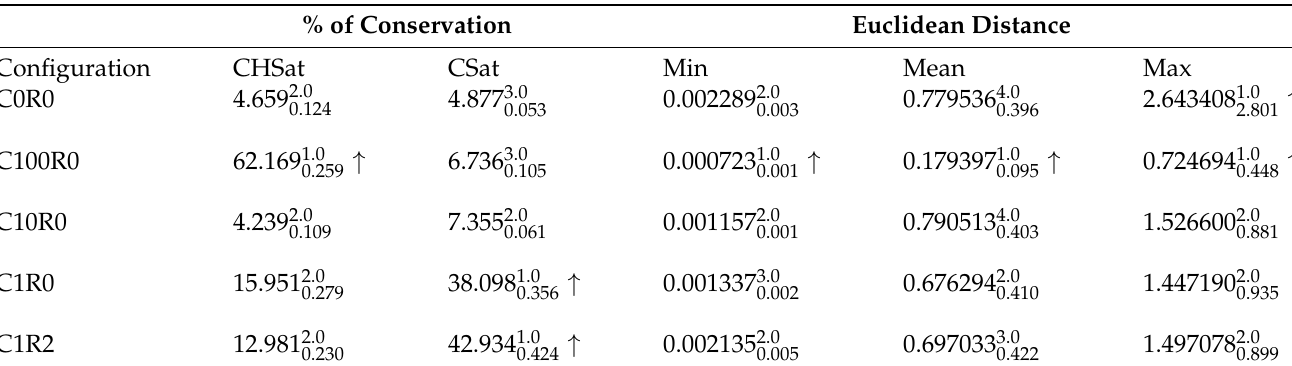
Table 6. The average and standard deviation of the algorithms over 50 independent runs in terms of percentage of conservation and Euclidean distance for the DTLZ family of